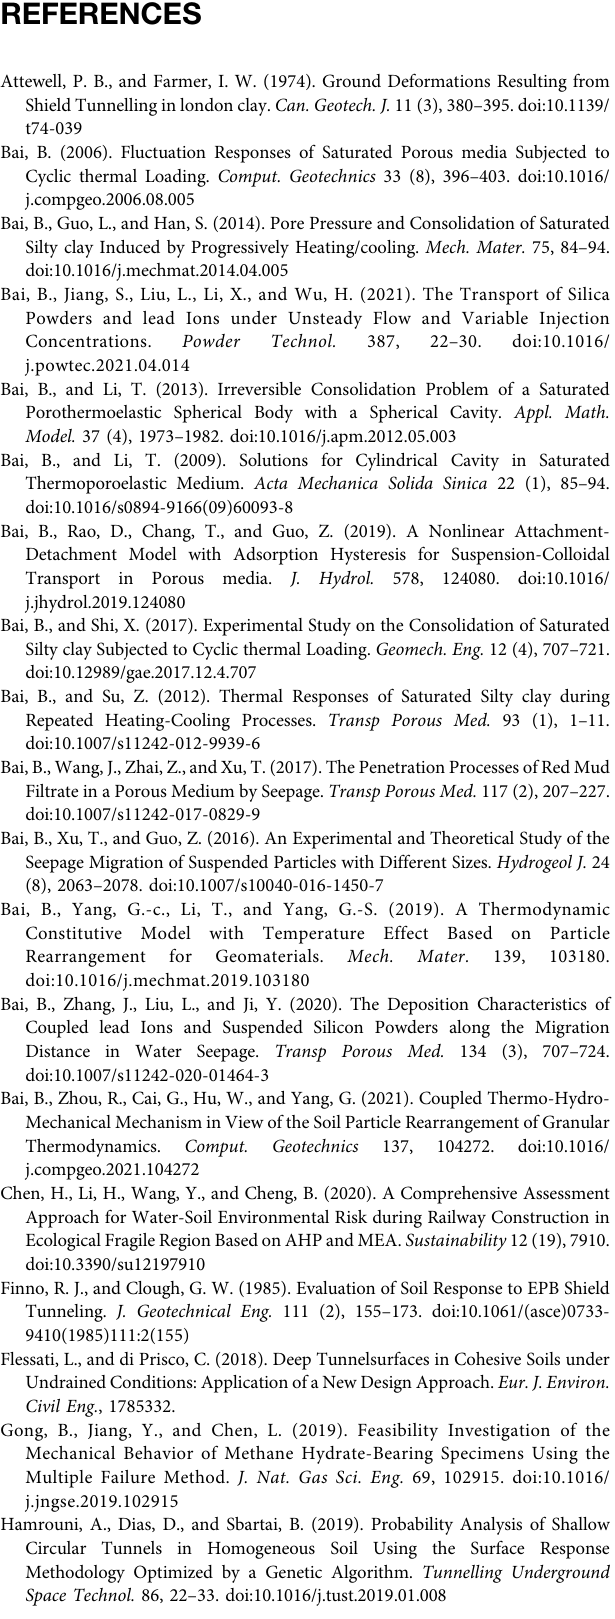
Frontiers in Earth Science |